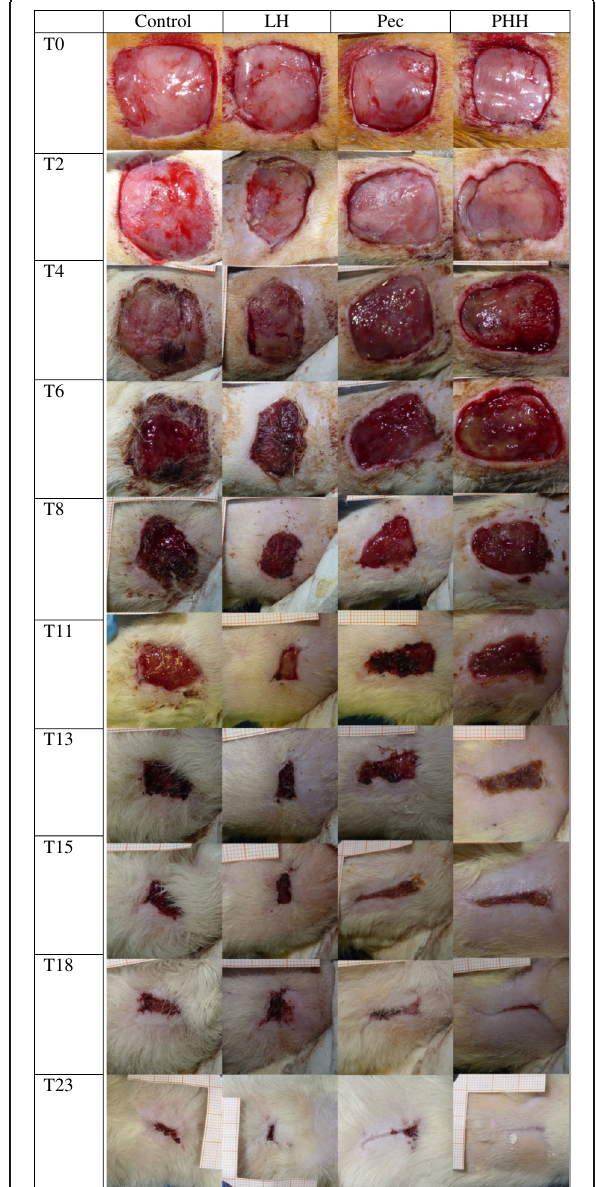
Fig. 1 Picture of wound healing of different groups at each time